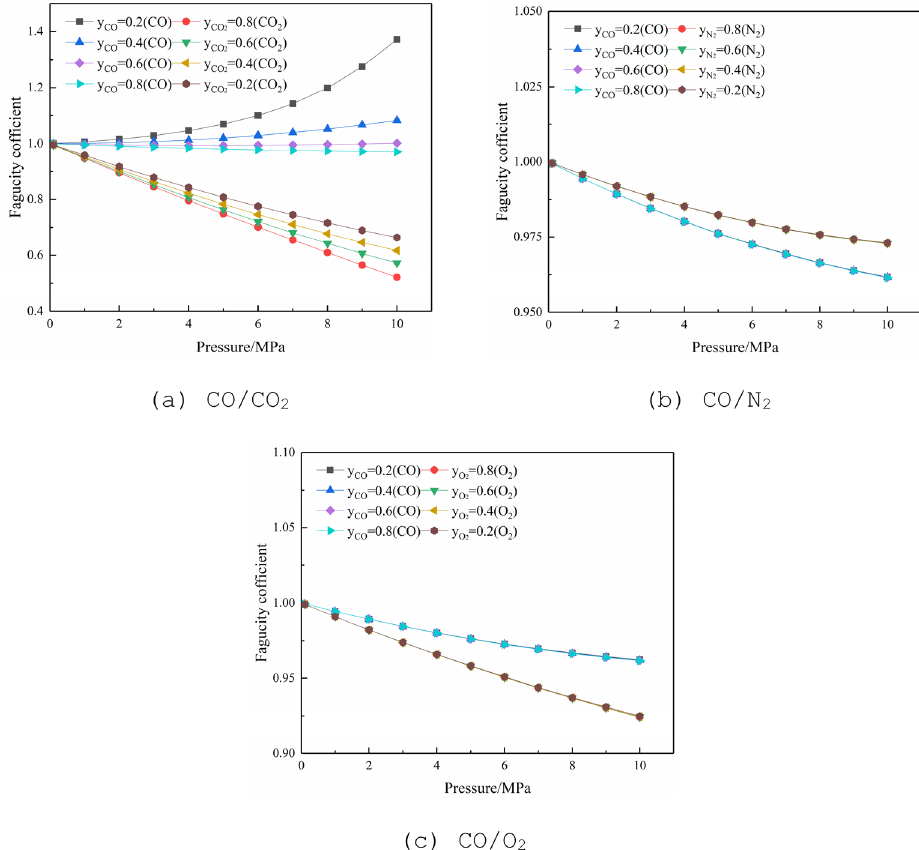
Figure 4. Relationship between fugacity coefficient and pressure of binary-components at 298.15